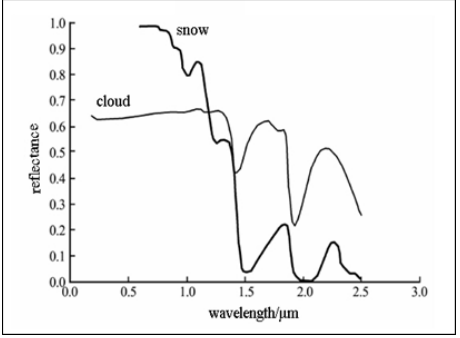
Figure 6. Cloud and snow reflection characteristics